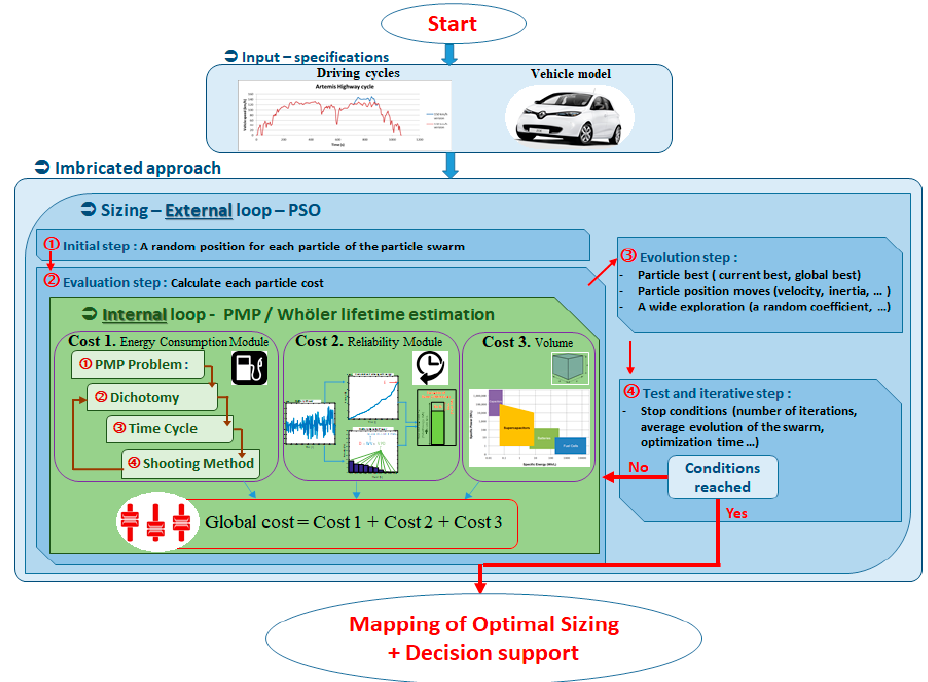
Figure 2. Workflow implementing the proposed nested decision support tool.